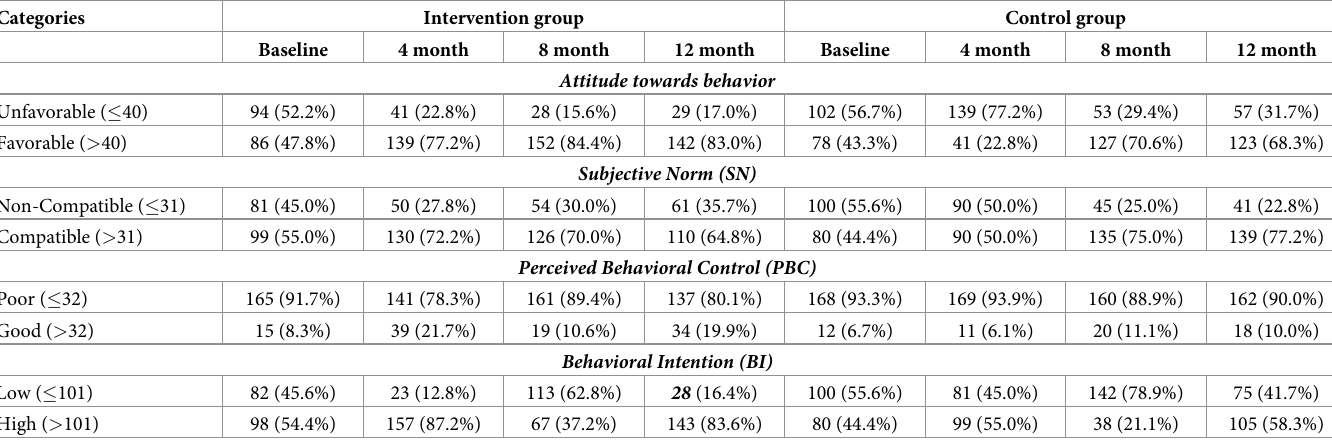
Table 4. Comparative frequency and percentage distribution of TPB constructs at different endpoints of mammography intention (n = 360).